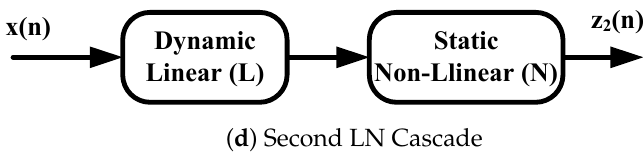
Figure 4. Step-by-step implementation of PCI